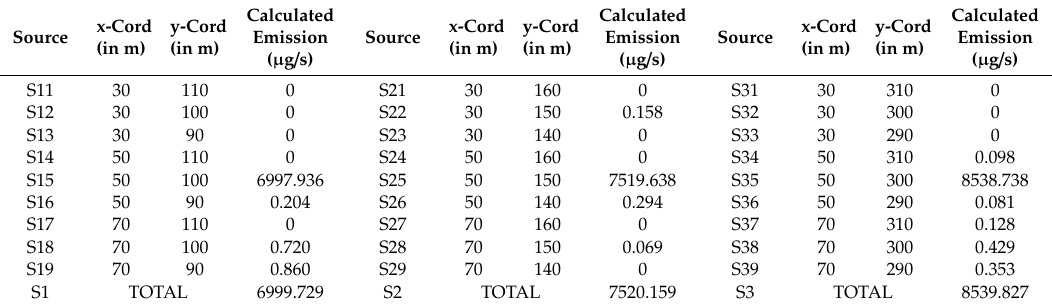
Figure 5. ( a ) One source in each of the three drydocks vs. ( b ) nine sources in each of the three drydocks. Table 5. Emission rates calculated in Step 4 for drydocks as an area source with nine source locations at each